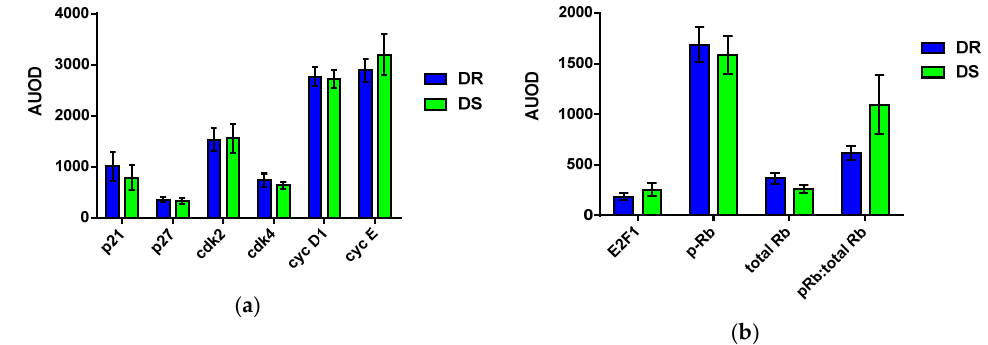
Figure 4. Expression levels (AUOD, arbitrary units of optical density normalized to glyceraldehyde 3-phosphate dehydrogenase (GAPDH) for proteins involved in G1/S transition. Tumors from dietary obesity sensitive (DS) and dietary obesity resistant (DR) rats were evaluated. Values are means ± SEM. Because expression of these proteins is interrelated, the overall impact of obesity status was evaluated by multivariate analysis techniques (Section 3.6.3).